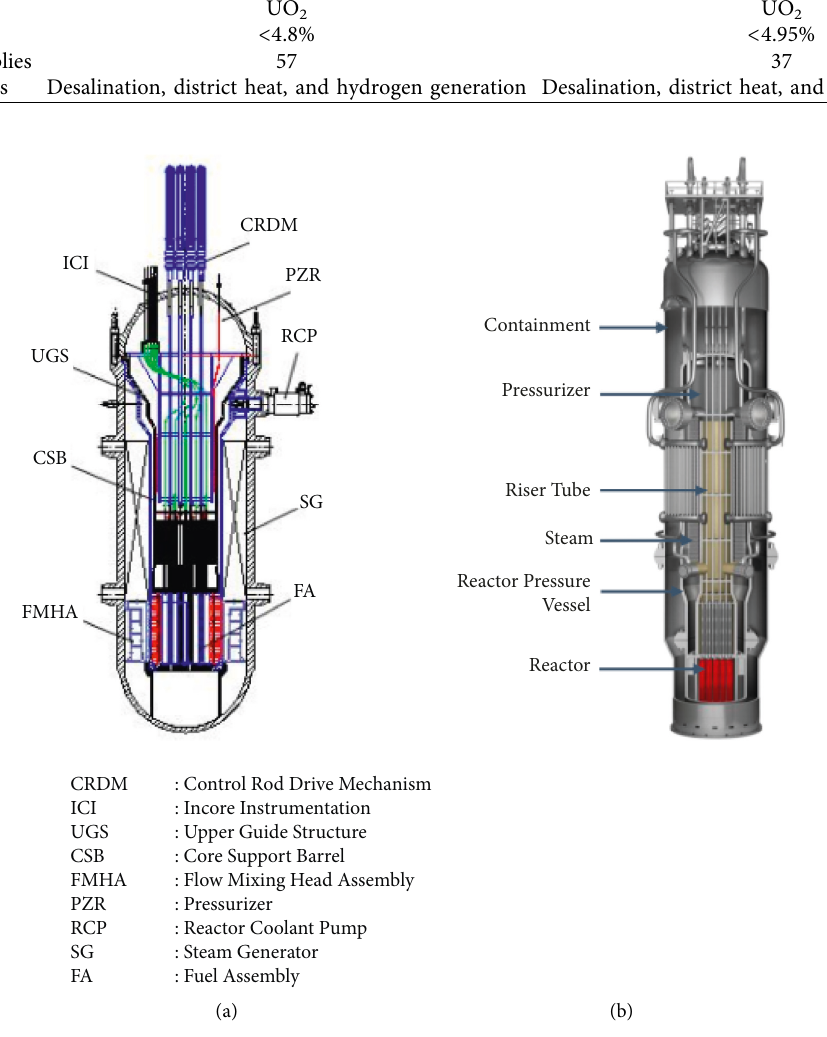
Figure 1: Structural diagram of SMART (a) and NPM (b) [15,